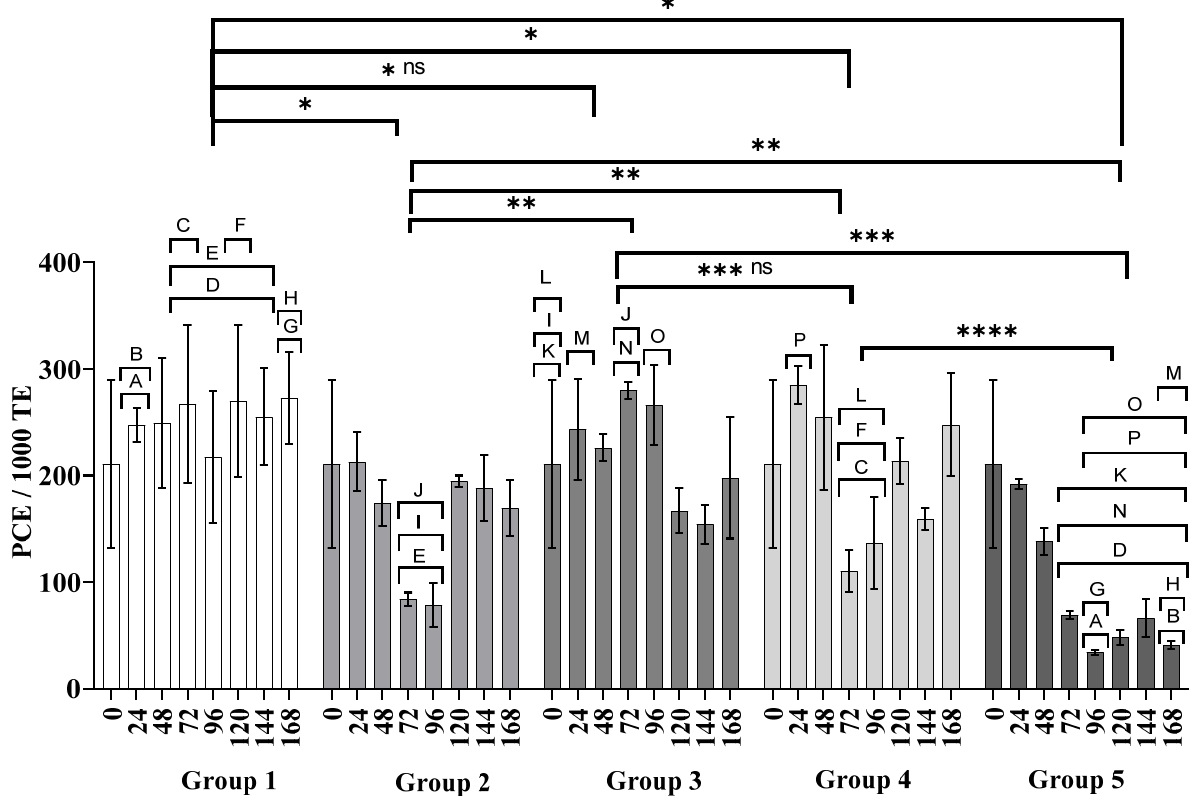
Figure 3. Polychromatic erythrocytes observed in 1000 total erythrocytes. Group 1: water (0, 24, 48 h), Group 2: CP (0 h), Group 3: AgNPs (0, 24, 48 h), Group 4: CP + AgNPs; CP (0 h) + AgNPs (24, 48, 72 h), and Group 5: CP + AgNPs; CP (0, 48, 96 h) + AgNPs (24, 72, 120 h). ns: no significant difference; *, **, ***, and **** denote statistically significant differences between groups ( p < 0.0001); letters A–P denote statistically significant differences between inter and intragroup concentrations ( p < 0.0001). Numeric data used to build the graph can be consulted in Table S1.